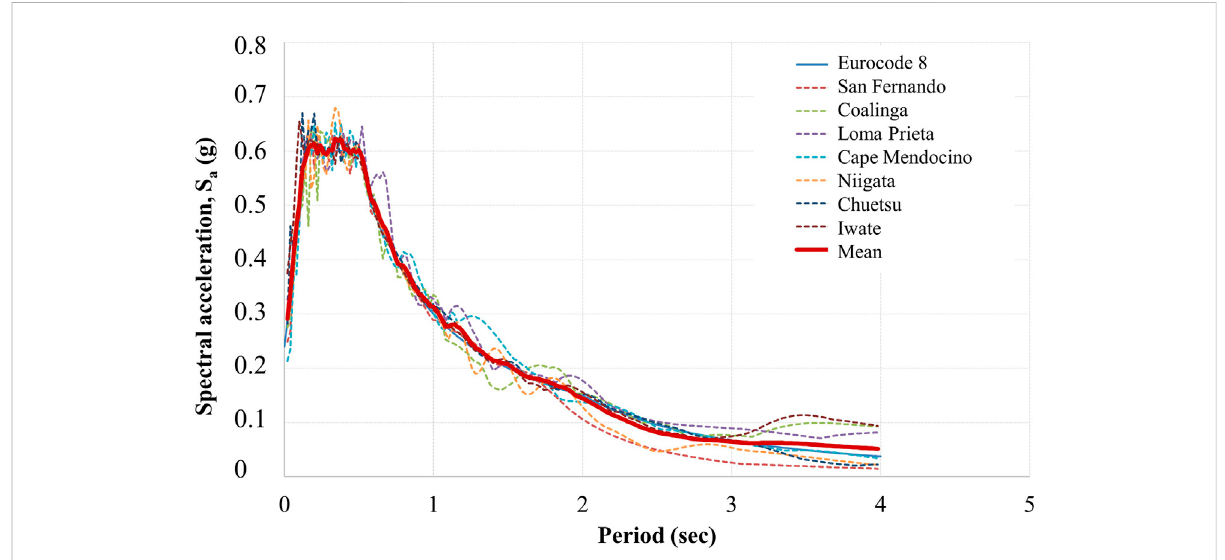
FIGURE 2 0.2 g scaled response spectrum to be used in adaptive pushover analyses.